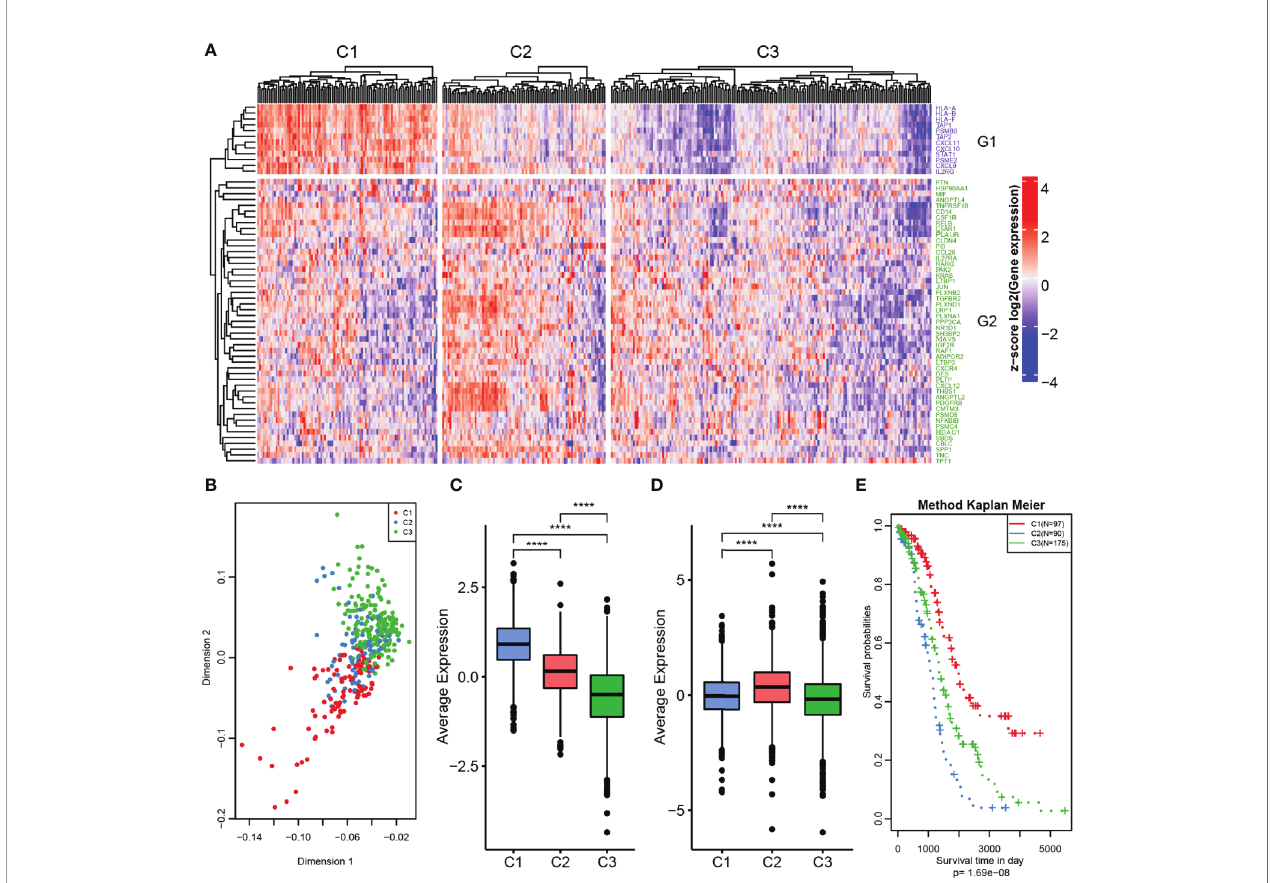
FIGURE 2 | OC immunotyping based on IRGs. (A) Gene expression heatmap of OC immune subtypes. (B) Principal component analysis of the differences between immune subtypes. (C) The expression difference distribution box plot of the G1 gene set between subtypes was analyzed. (D) The expression difference distribution box plot of the G2 gene set between subtypes was analyzed. (E) The K-M curve of overall survival rate of immune subtypes in TCGA dataset was tested by log rank test. ****P <